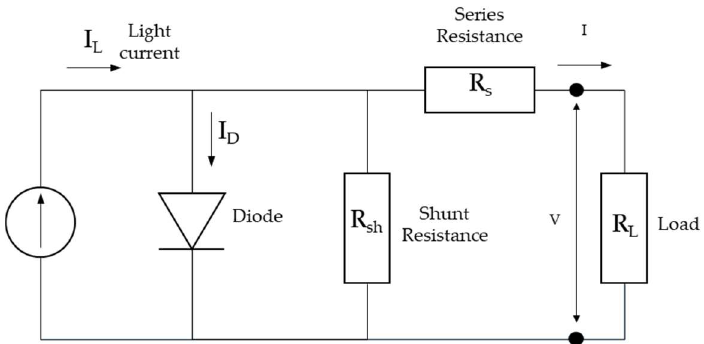
Figure 6. One-diode equivalent circuit for PV performance modeling. Table 2. Summary of simulation research articles for T- and ST-BIPV reviewed.